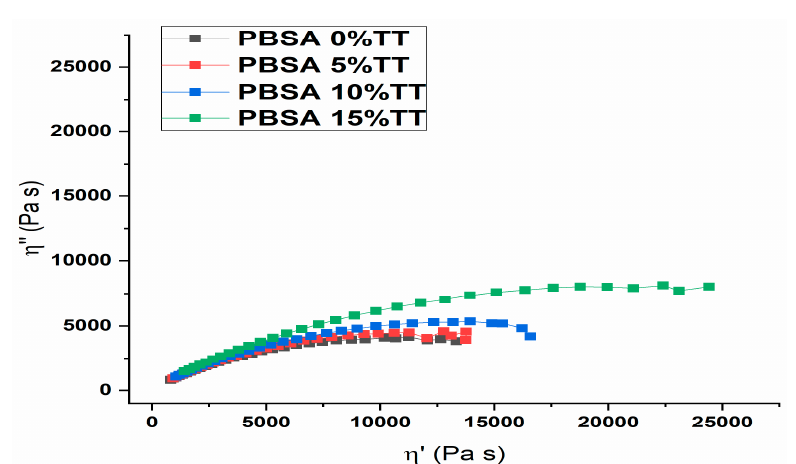
Figure 7. Complex plane diagrams for all the composites at T = 180